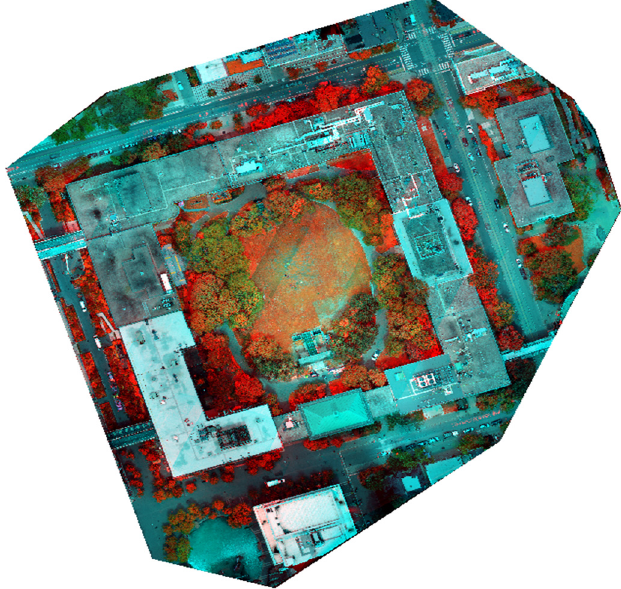
Figure 18. False-color combination of the fused image for the second test site.